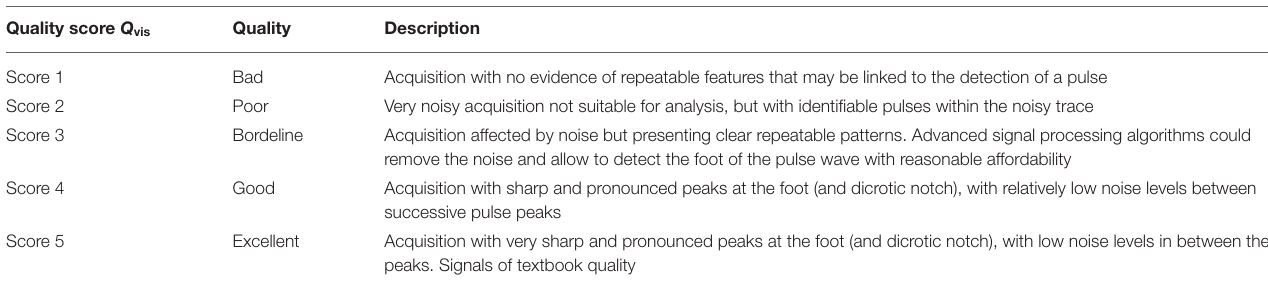
TABLE 1 | The 5-levels grade scale taking values Q vis